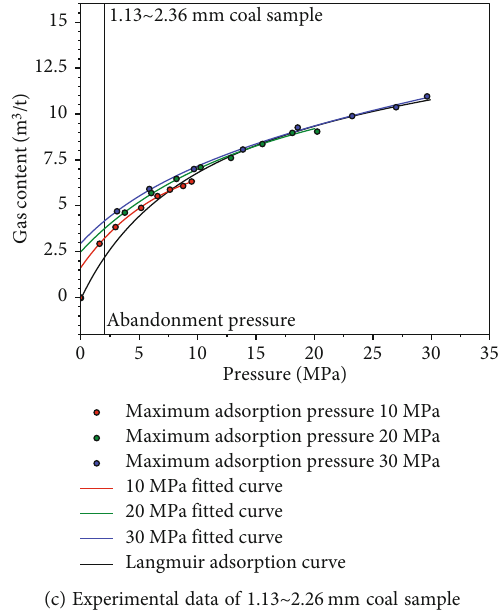
Figure 4: Comparison of isothermal desorption lines of methane at di ff erent highest adsorption